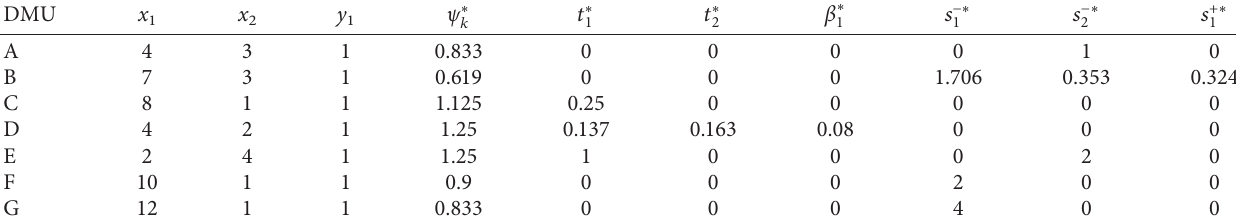
Table 3: Results from our model (10).